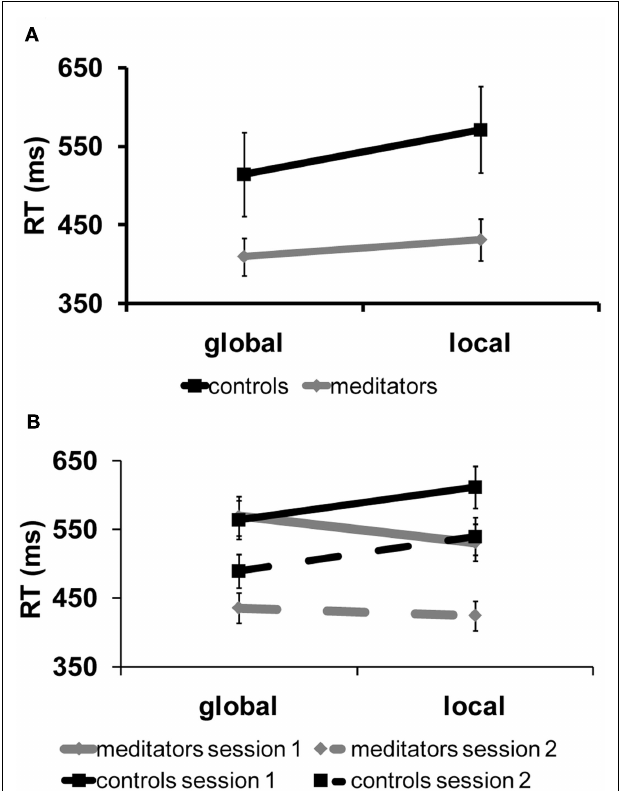
FIGURE 2 | Behavioral results, cross-sectional, and longitudinal study. (A) Results of the cross-sectional experiment. Reaction time for targets at the local and global level separated per group. In black: controls, in gray: meditators.The reaction time data shown here reveal a reduction in the global precedence effect in the meditation group as compared to the control group. (B) Behavioral results of the longitudinal study. Reaction time for targets at the local and global level separated per group and per session. In black: controls in gray: meditators. Solid lines correspond to session 1 and dashed lines correspond to session 2. In meditators, precedence was modulated by the retreat whereas there was no session effect in controls. Meditators with FA training responded faster to local stimuli before the retreat. After the OM retreat this effect was significantly reduced. Controls responded faster to global than to local stimuli, as